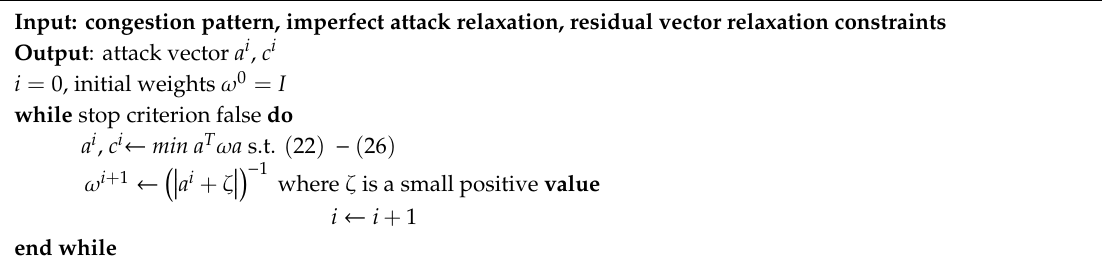
Algorithm 1. Iteratively reweighted (cid:96) 2 − norm minimum